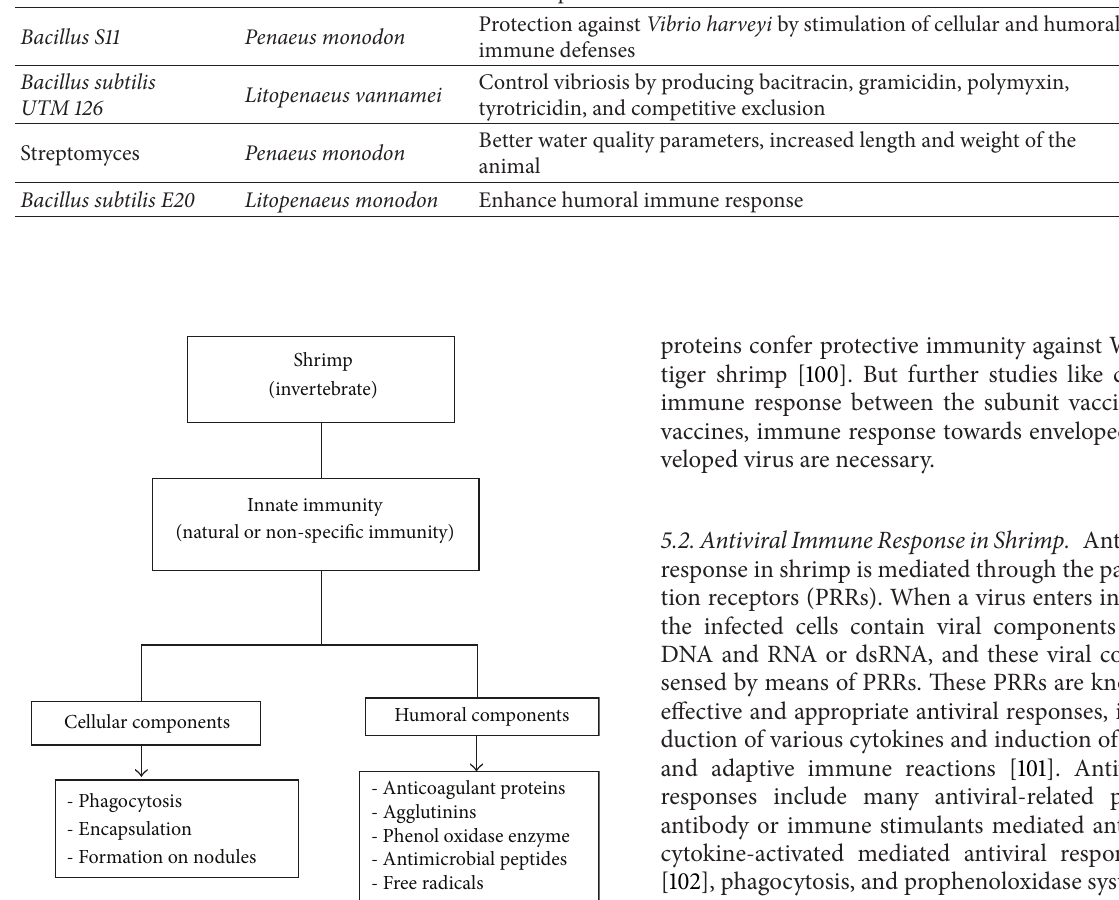
Figure 3: Outline of immune defense system in